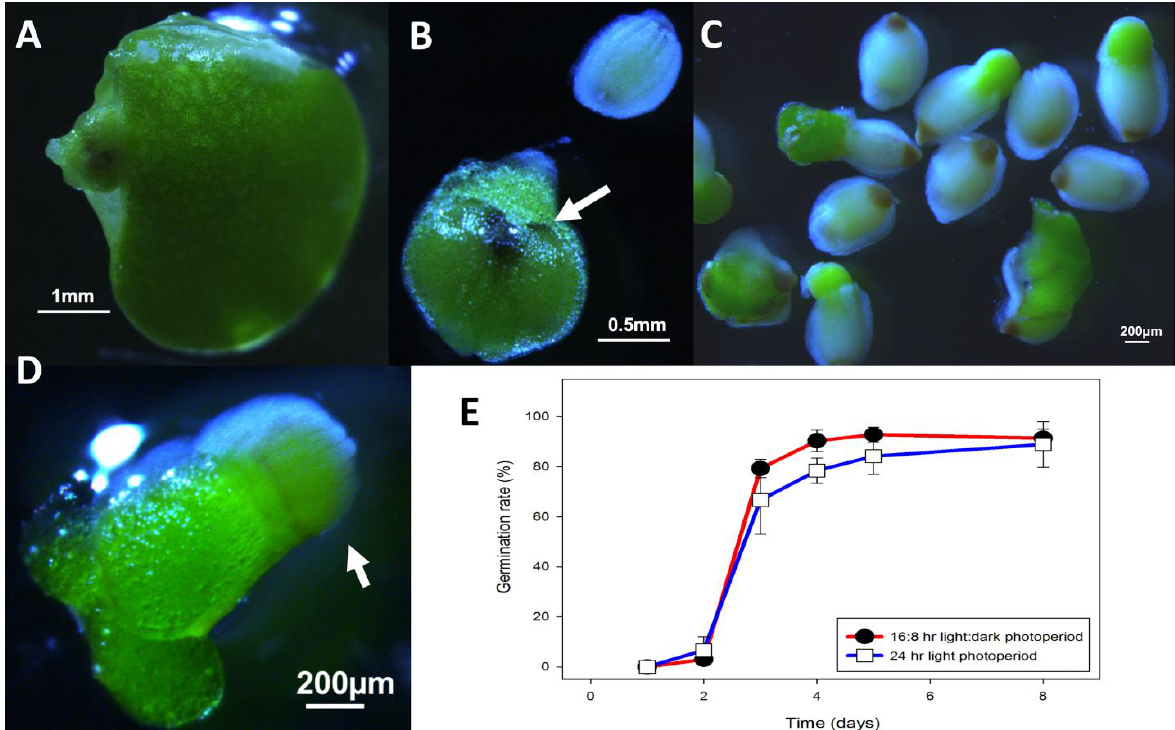
Figure 10. L. gibba G3 DWC114 seed development and germination ( A ) Developing seed growing in the meristematic pouch, ( B ) Detached fruit with 2 developing seed. Note the two hyperpigmented spots, which are the opercula (white arrow). The operculum is visible on the free seed, which shows the typical ribbing on the seed coat. ( C ) Germinating seed showing emergence of the new green frond together with ungerminated seed at the bottom of the culture vessel. ( D ) A seedling floating on the surface of the medium still attached to the seed coat (white arrow), and already undergoing asexual budding. ( E ) Germination percent of seed over eight days in E in multi-well plates in LD or CL lighting conditions. Data are the average ± SEM ( n = 3).